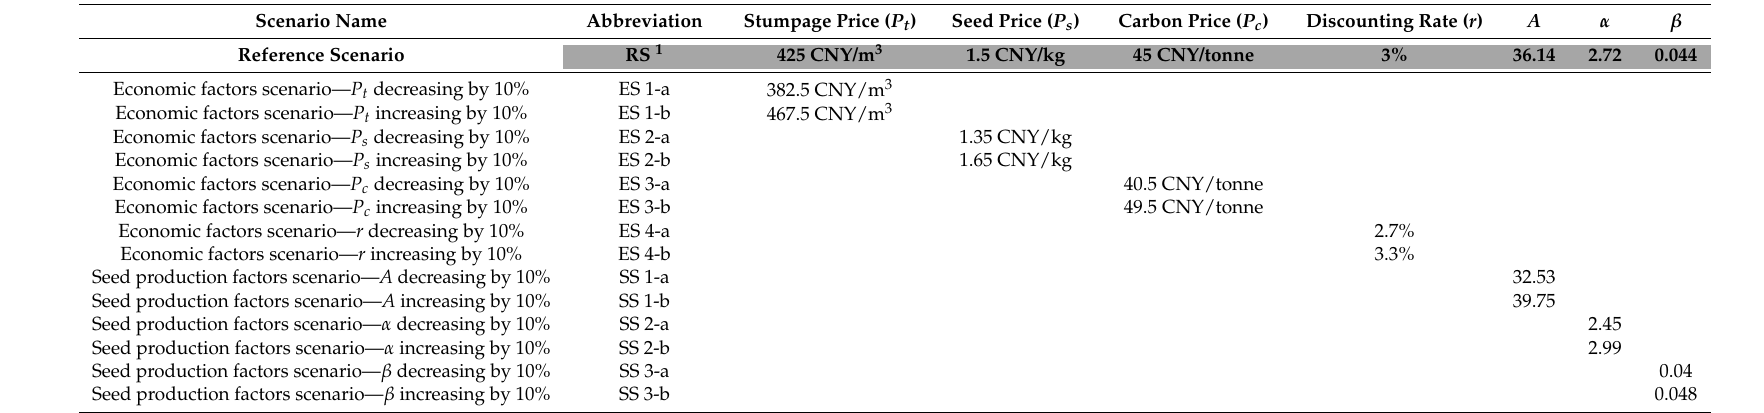
Table 4. Scenarios with Corresponding Abbreviations and